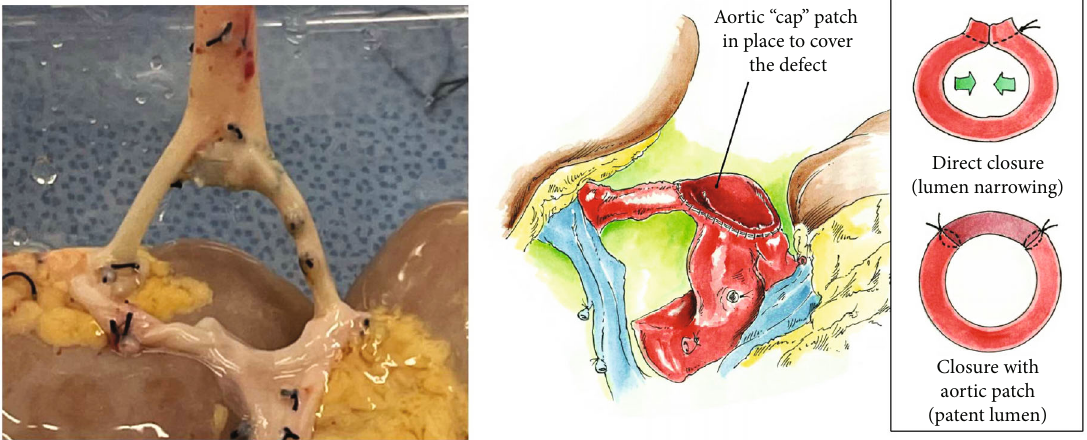
Figure 2: Reconstruction of the aorta and ostium of the right renal artery with the aortic patch from the same donor.